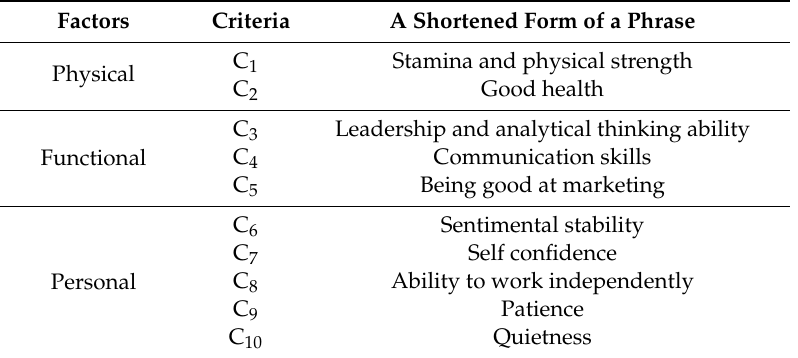
Table 3. Criteria for CEO selection.